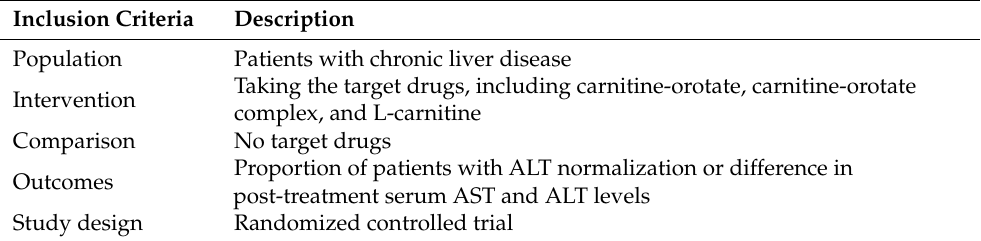
Table 1. Inclusion criteria of the present meta-analysis. ALT, alanine aminotransferase; AST, aspartate